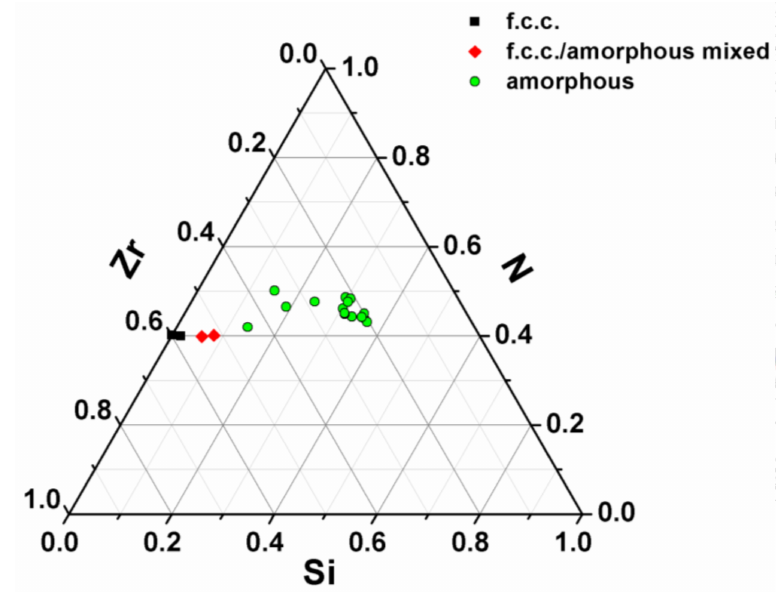
Figure 2. Phase distribution of Zr–Si–N